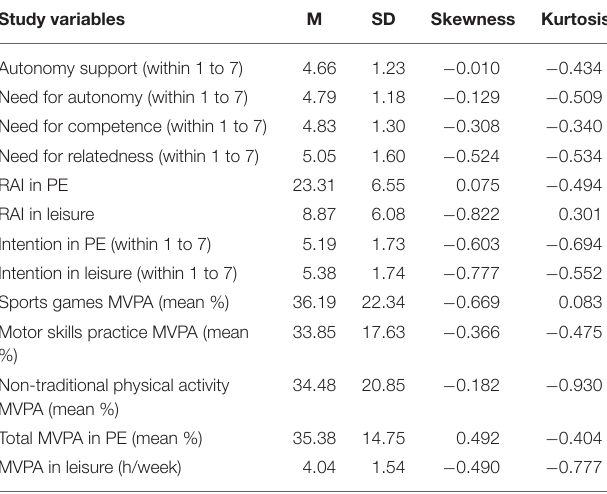
TABLE 1 | Descriptive statistics of study